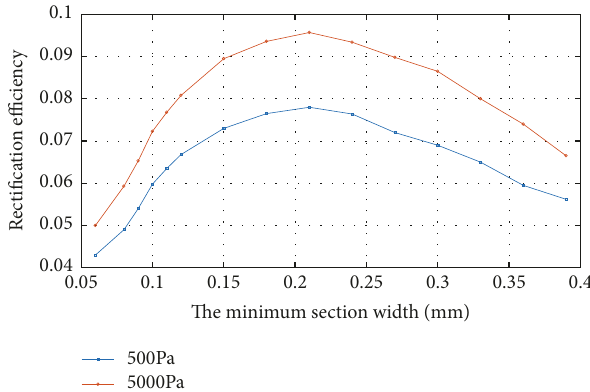
Figure 10: Relationship between the minimum section width and the rectification efficiency.